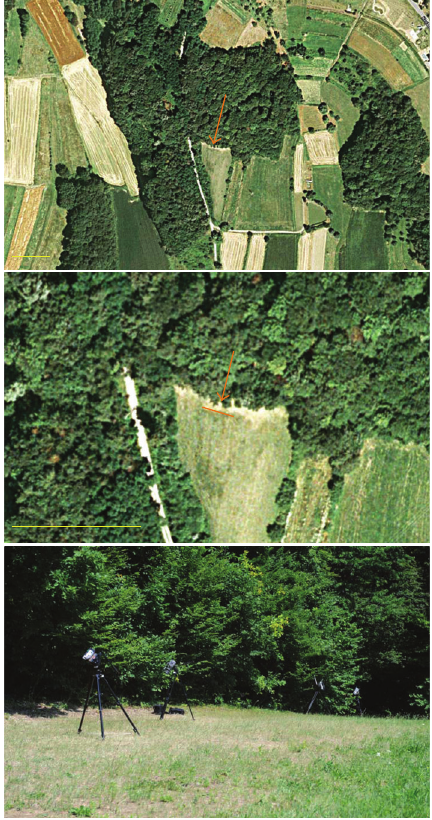
Figure 2: Study site. A strip of 5 × 24m (orange bar in the middle image and orange arrows) near the edge of a forest in Krobotek (46 ◦ 58’N, 16 ◦ 11’E) in southern Burgenland (Austria) at an altitude of 300 m sea level was selected as the study site. An aggregation of 159 nests of Halictus scabiosae was found in a meadow with thermophilic vegetation on sandy-loamy soil. Yellow scale bars represent 100m in length. The orange area and the arrows mark the study patch. The bottom image shows the four camcorders on tripods filming the activities at four selected batches as defined in Figure 3.